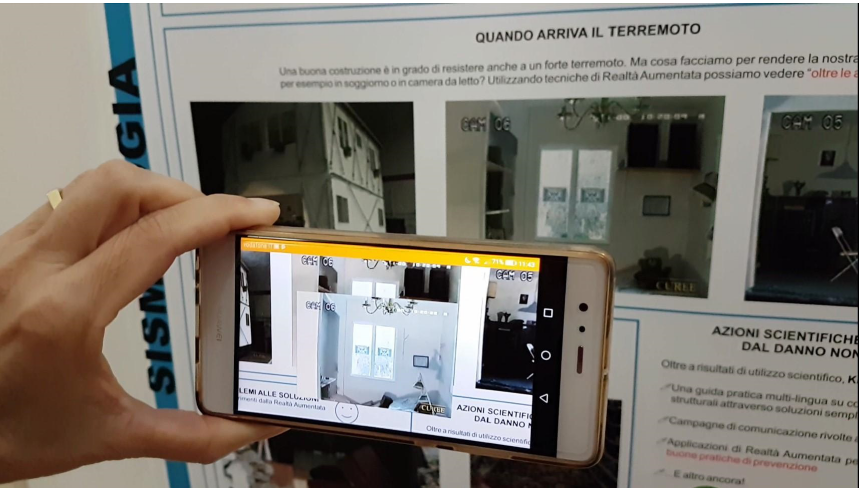
Figure 2. AR user looking at a video of a shaking table test, which simulates non-structural damage within a child’s room. The video can be freely downloaded from UC Berkeley (http://seismo.berkeley.edu/~rallen/seishaz/buildings/CUREEtest/ (accessed on 21 January 2022)).